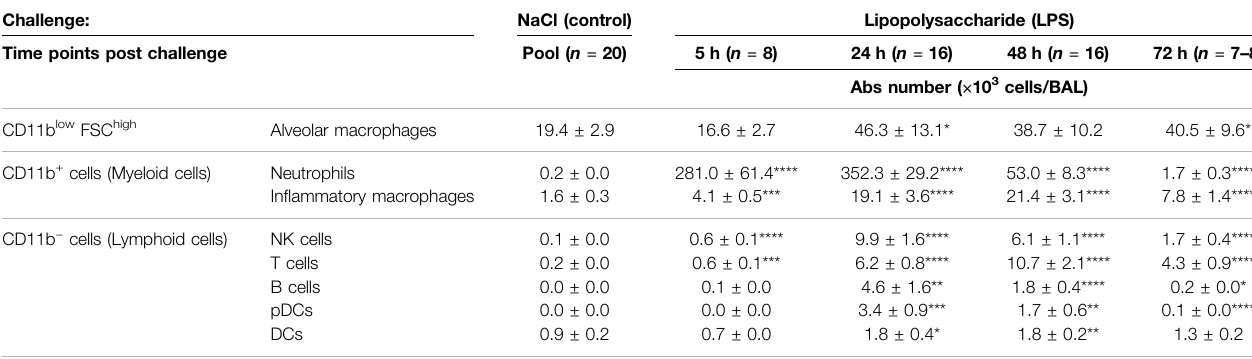
TABLE 1 | Time course of immune cells present in the bronchoalveolar lavage (BAL) following LPS or NaCl challenge in DBA/1 mice.